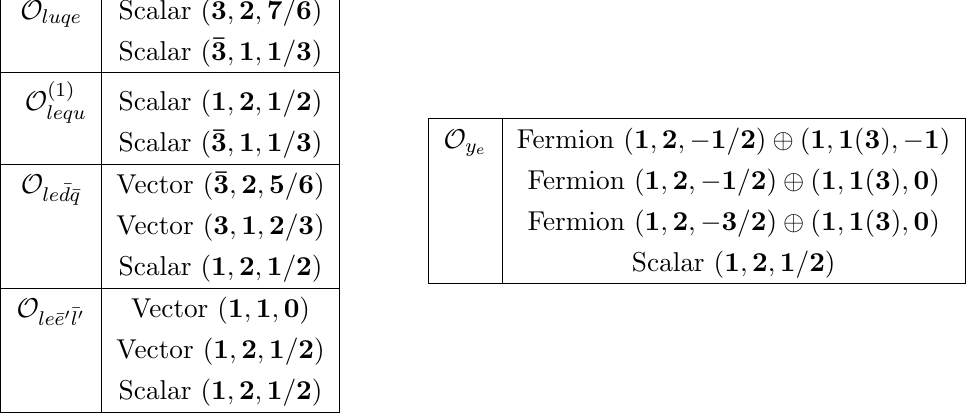
Table 3 . States transforming under the SM group SU(3) tree-level to the operators of table